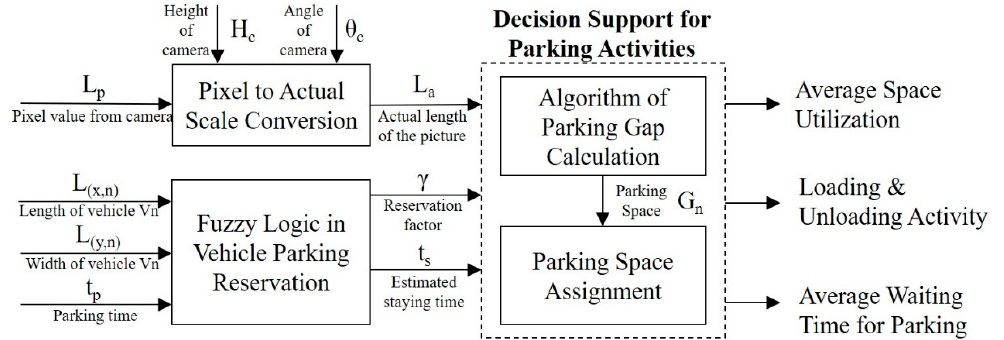
Figure 5. Overview of the computations in the CVROSS.